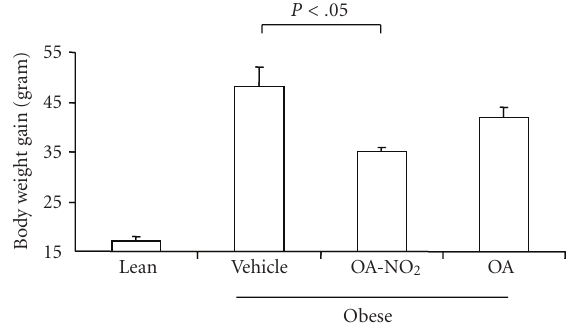
Figure 2: Body weight gain in obese Zucker rats before and after 14-d infusion with vehicle, OA-NO 2 , or OA. Lean rats with vehicle treatment were used as controls. Lean: n = 3; Vehicle: n = 7; OA- NO 2 : n = 5; OA: n = 5. Data are mean ± SE.